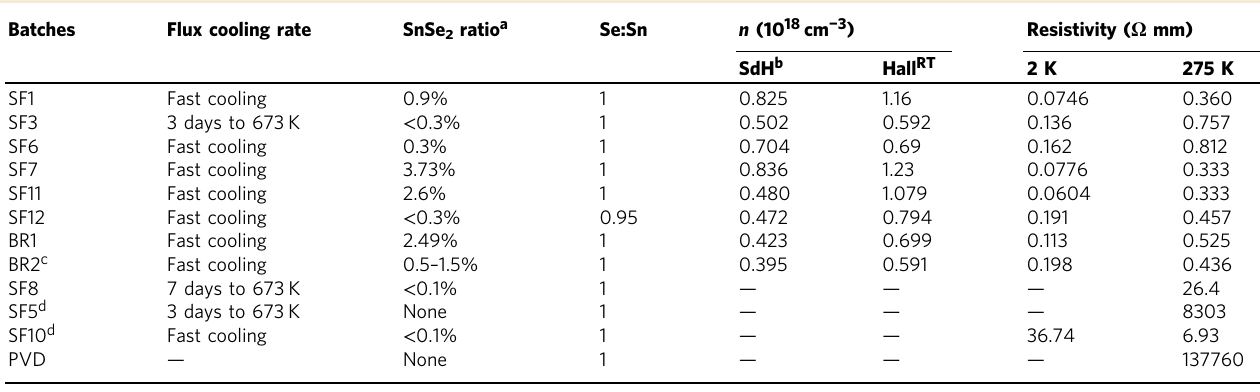
Table 1 Physical properties of SnSe single crystals grown by three different methods Batches SF1